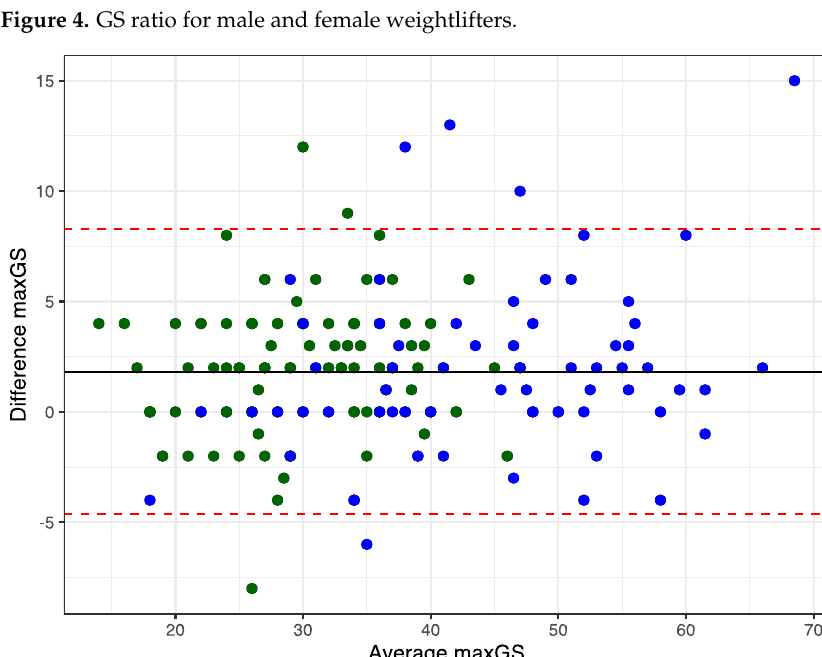
Figure 5. Bland–Altman plot for GS measurements for both hands. Females (green) and males (blue).